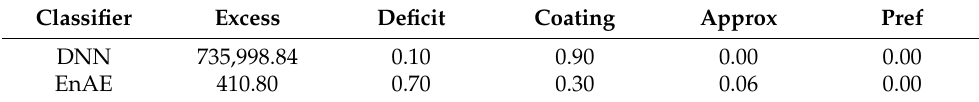
Table 10. DNN and EnAE quality assessment by Table 9. DNN and EnAE quality assessment by traditional criteria.